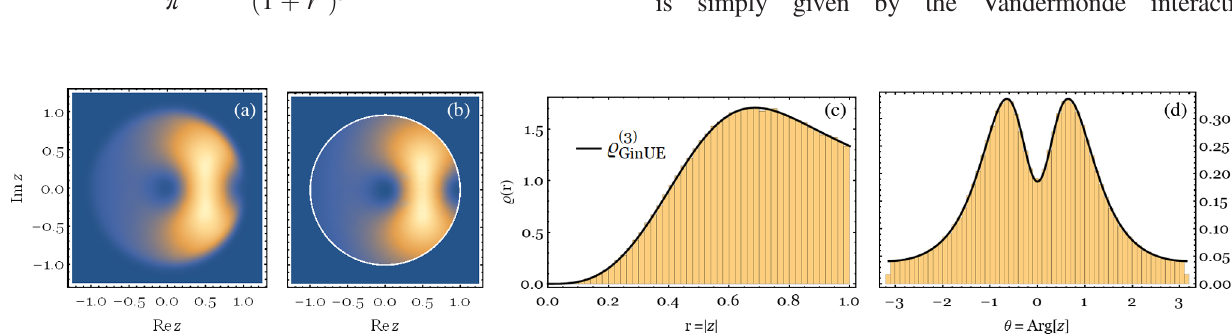
FIG. 14. Comparison of exact diagonalization (ED) of GinUE-drawn matrices with analytical results, for N ¼ 3 . (a) Ratio density from ED; (b) exact distribution, Eq. (C7); (c) histogram of absolute value of ratios from ED; (d) histogram of argument of ratios from ED; black lines are computed from Eq.